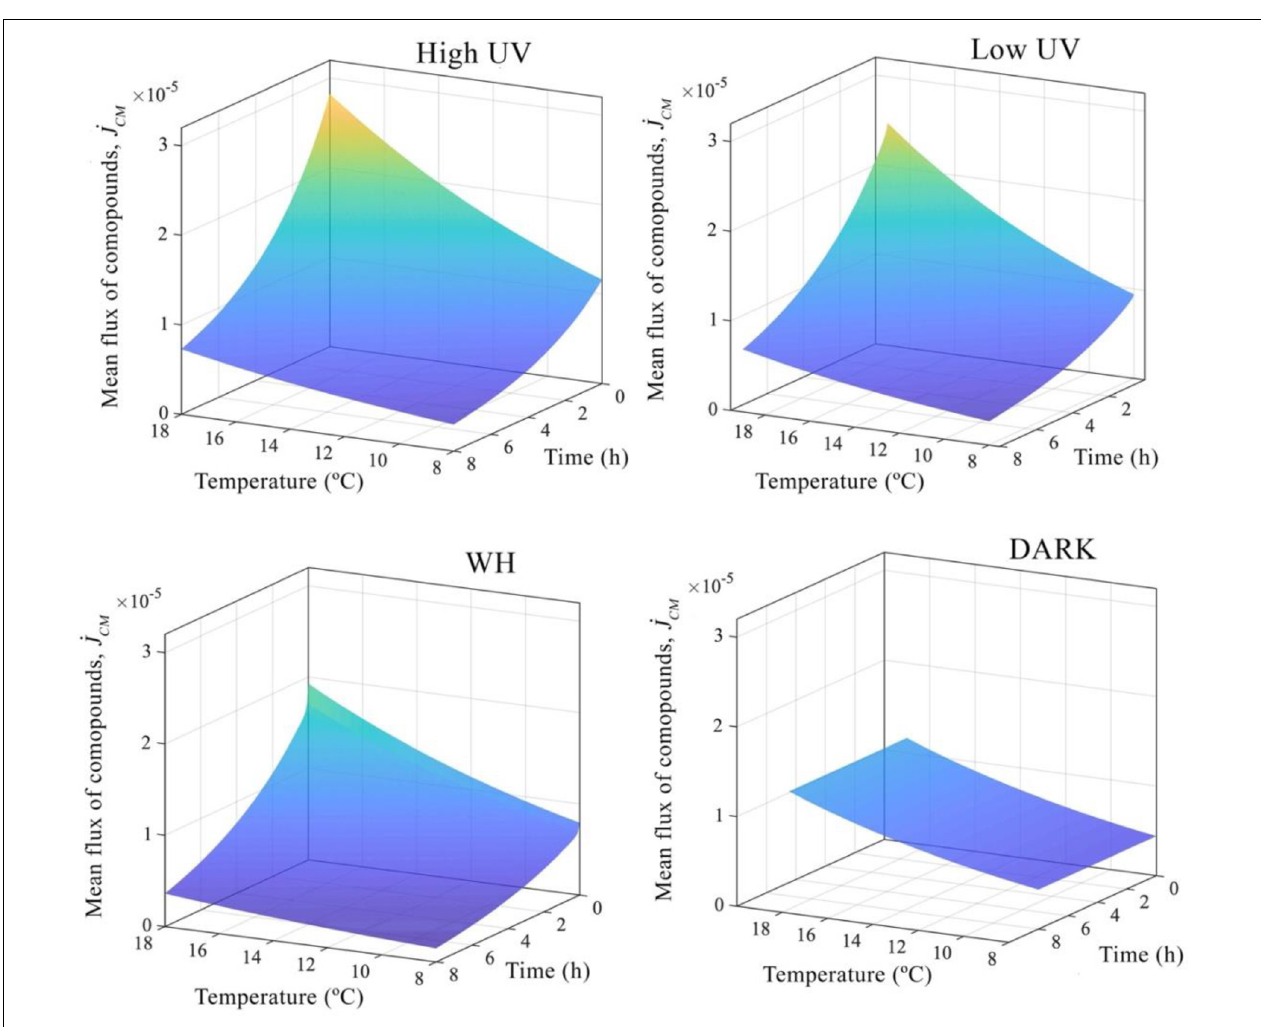
FIGURE 6 | Mean changes in energy fluxes. Nyctiphanes australis energy fluxes from the reserve to cover somatic maintenance.